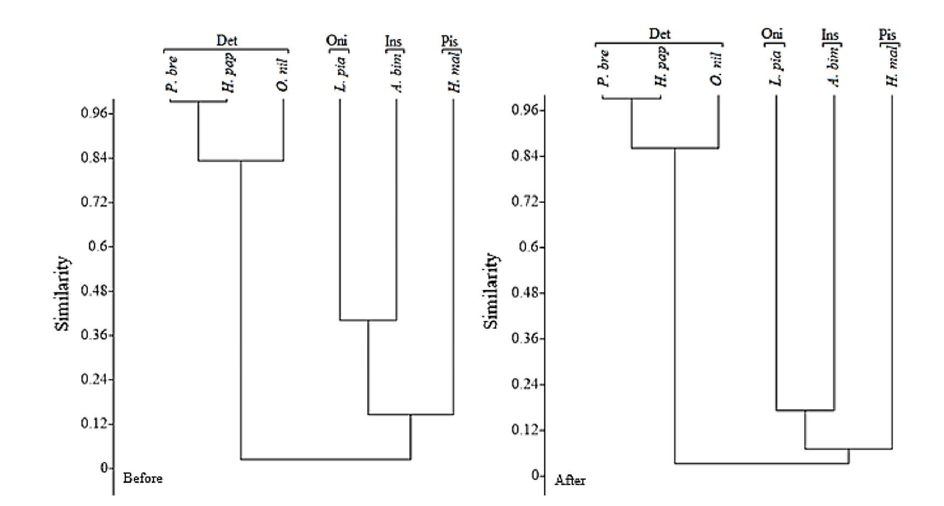
Figure 3. Food similarity dendrogram from the Alimentary Index (IAi) of the studied fish species, before (Cophen. corr.: 0.98) and after (Cophen. corr.: 0.98) the biomanipulation experiment at the Estação Ecológica do Seridó (ESEC-Seridó), Serra Negra, Rio Grande do Norte, Brazil.